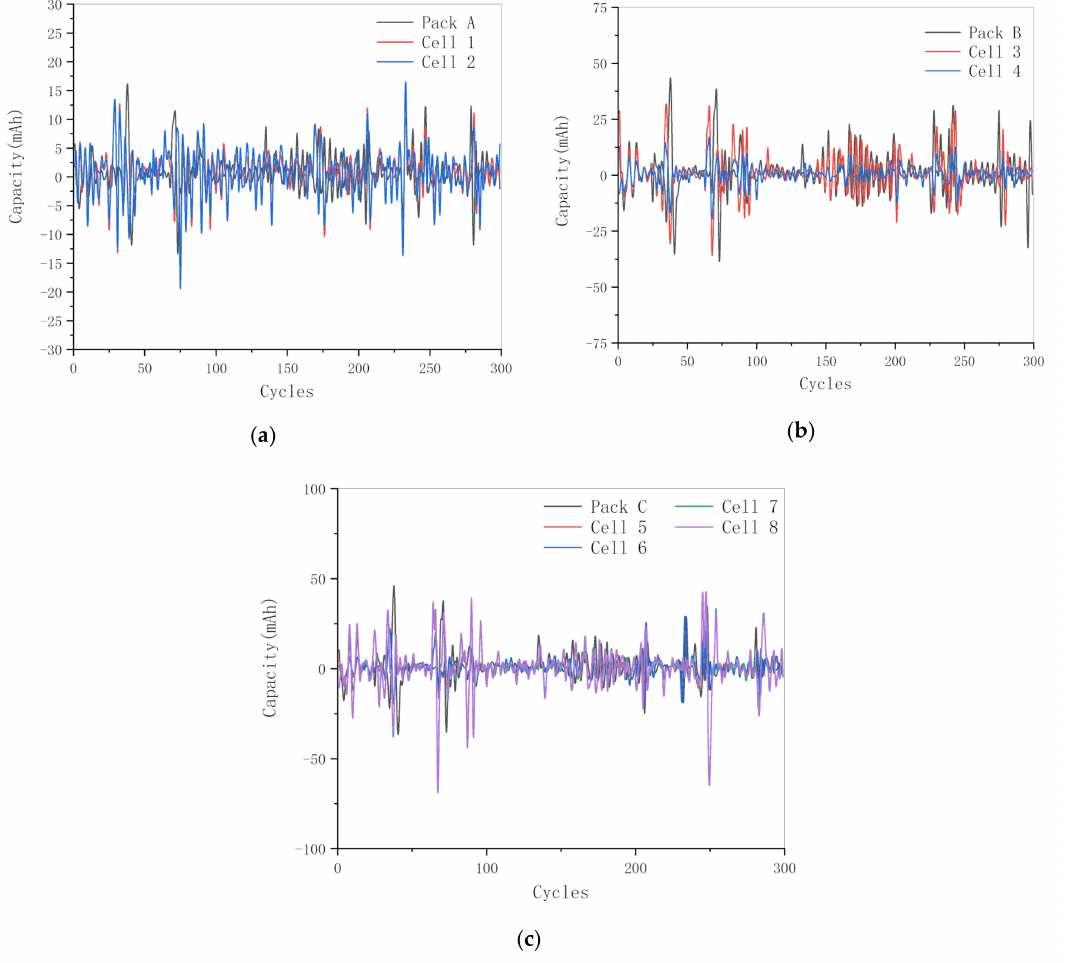
Figure 8. Inter-cycle capacity degradations: ( a ) Pack A; ( b ) Pack B; ( c ) Pack